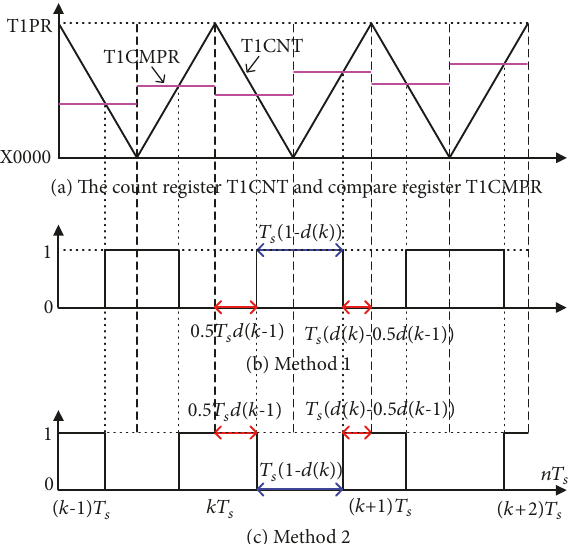
Figure 12: The implementation principle of the proposed modula- tion method based on the DSP2812